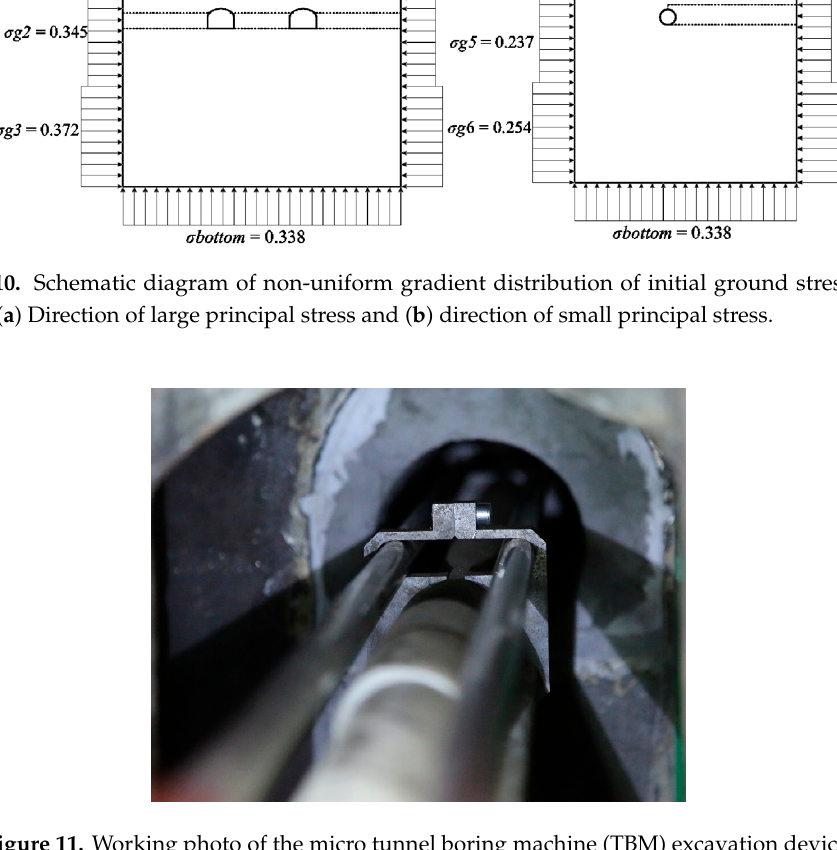
Figure 10. Schematic diagram of non-uniform gradient distribution of initial ground stress of the model. ( a ) Direction of large principal stress and ( b ) direction of small principal stress.